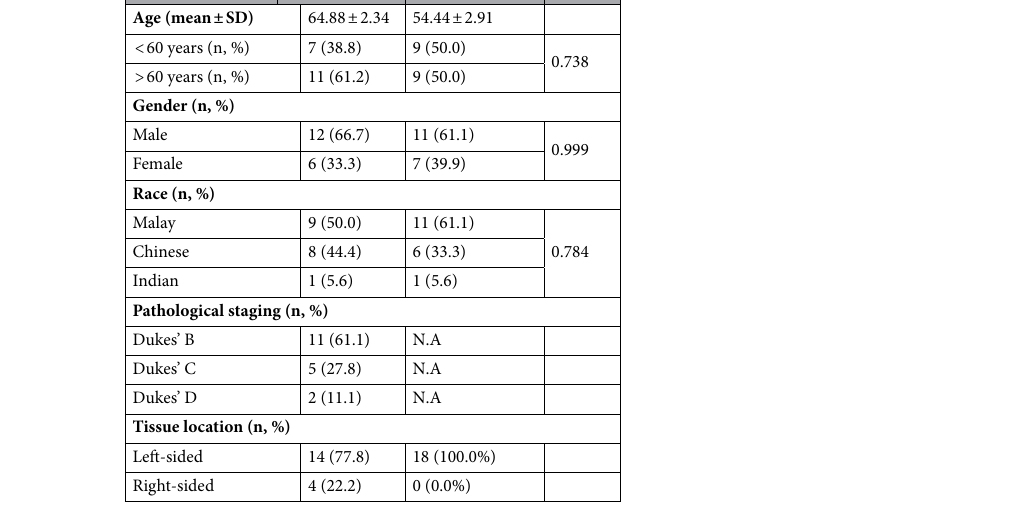
Table 1. Demographics of discovery phase study